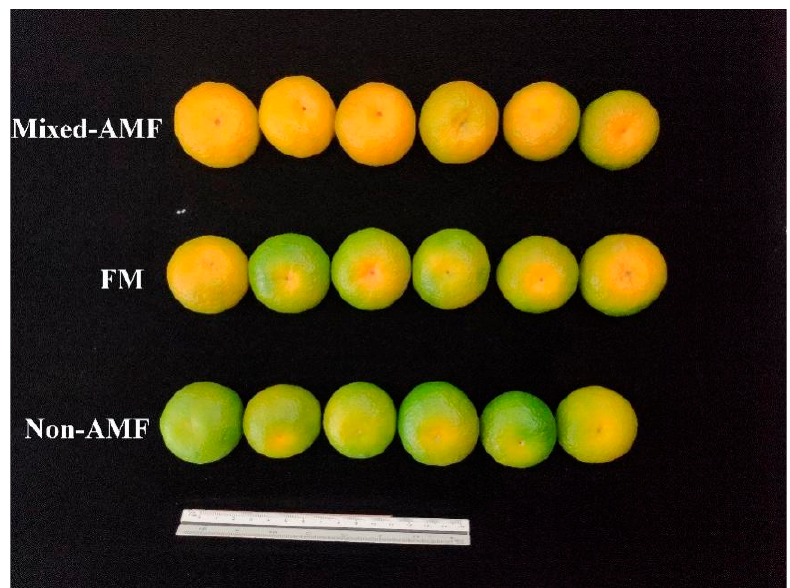
Figure 4. Changes in the appearance of fruits of Ponkan mandarin inoculated with Funneliformis mosseae (FM) and mixed-AMF, compared to uninoculated variety (non-AMF). The data were collected in 2019, the second year after AMF inoculation.